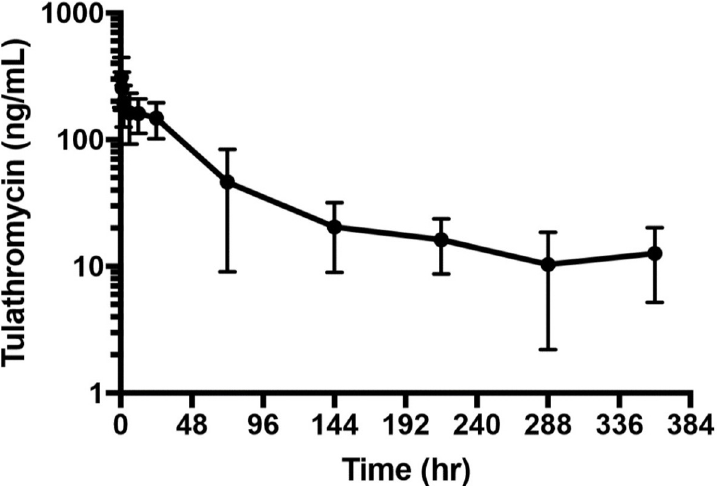
Fig 1. Plasma tulathromycin concentrations (ng/ml) over time (hours). Data are presented on a log10 scale with mean and one standard